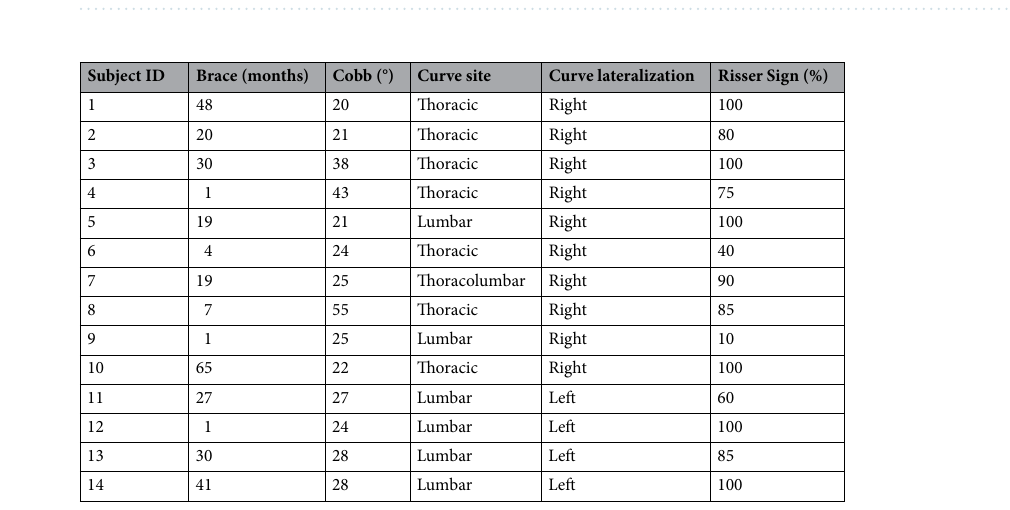
Table 2. Controls’ descriptive characteristics.